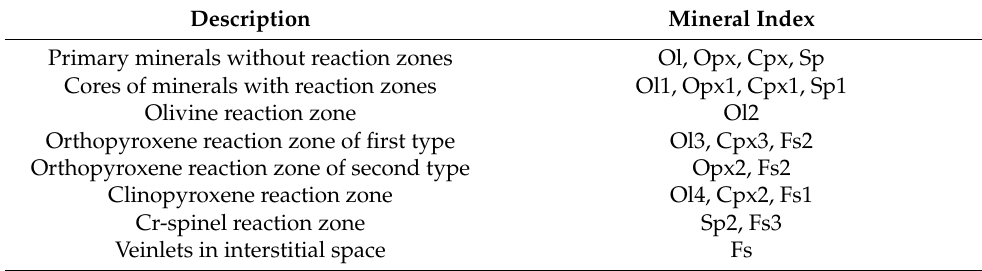
Table 1. Summary of the mineral assemblages of Tumusun